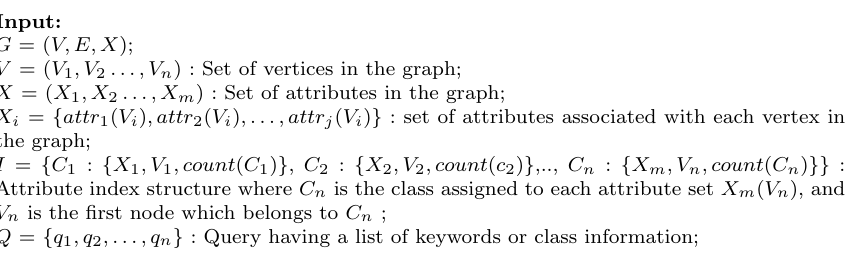
Algorithm 2 Personalized Community